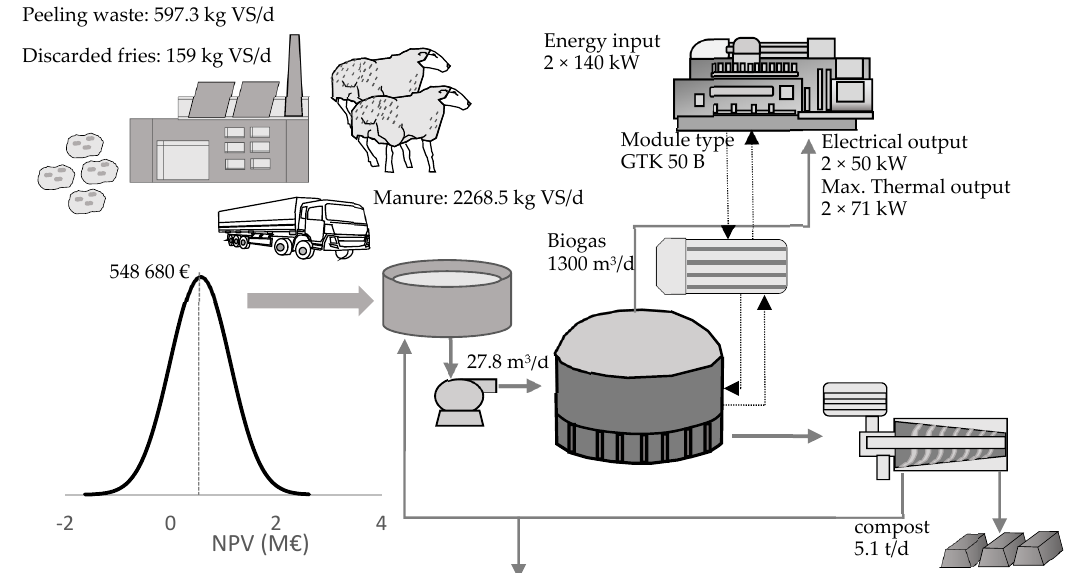
Figure 9. Main characteristics of co-digestion plant for treating a mixture of sheep manure and potato processing waste. Transport costs were estimated for both substrates.